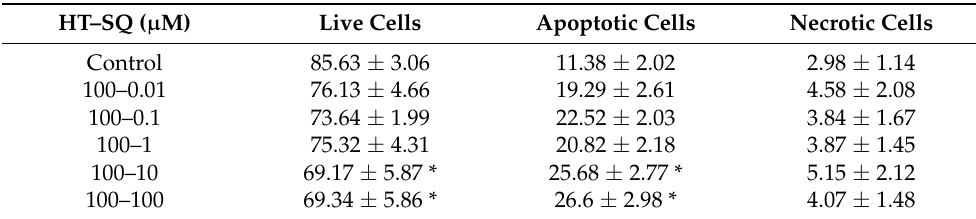
Table 3. Apoptosis of MDA-MB- 231 cells treated with HT at 100 μM combined with SQ (from 0.01 to 100 μM) after 2 4 h of treatment plus 24 h of fresh medium.